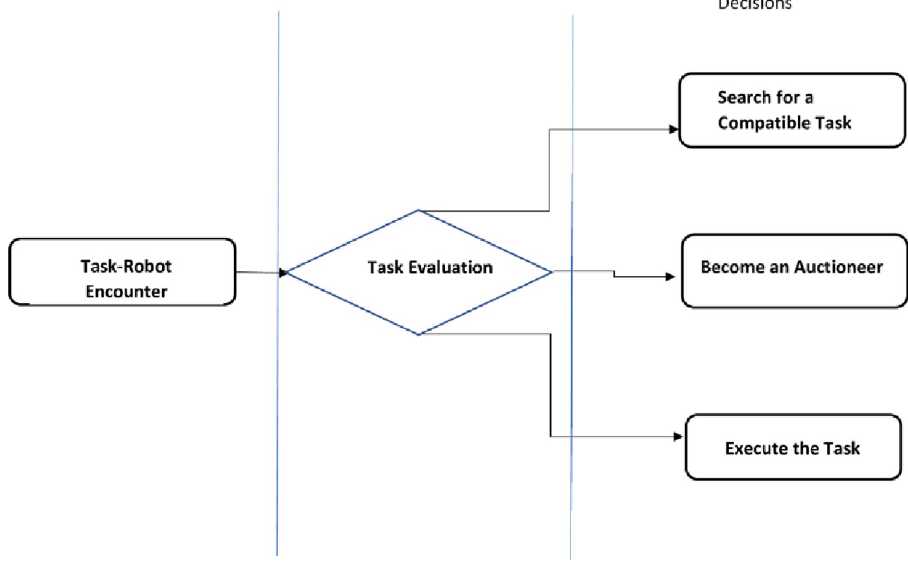
Fig 2. Generalized methodology for the proposed resource sharing